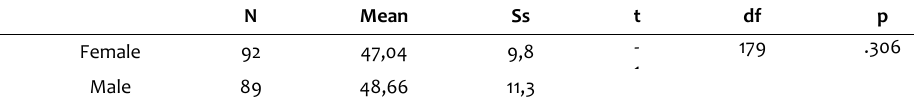
Table 3. Independent groups t-test table based on the scores of teachers' attitude scale according to gender variable N Mean Ss